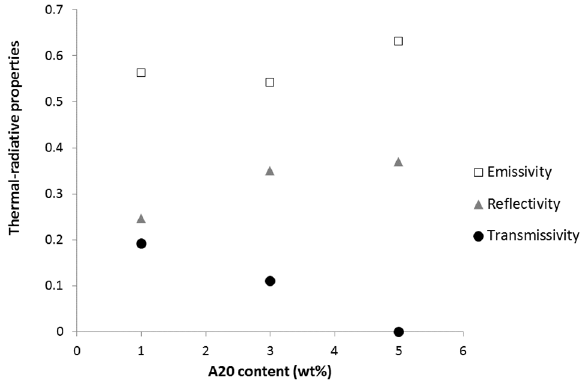
Figure 4. Effect of A20 content on emissivity, reflectivity and transmissivity of coatings (error bars are lower than the data points size).